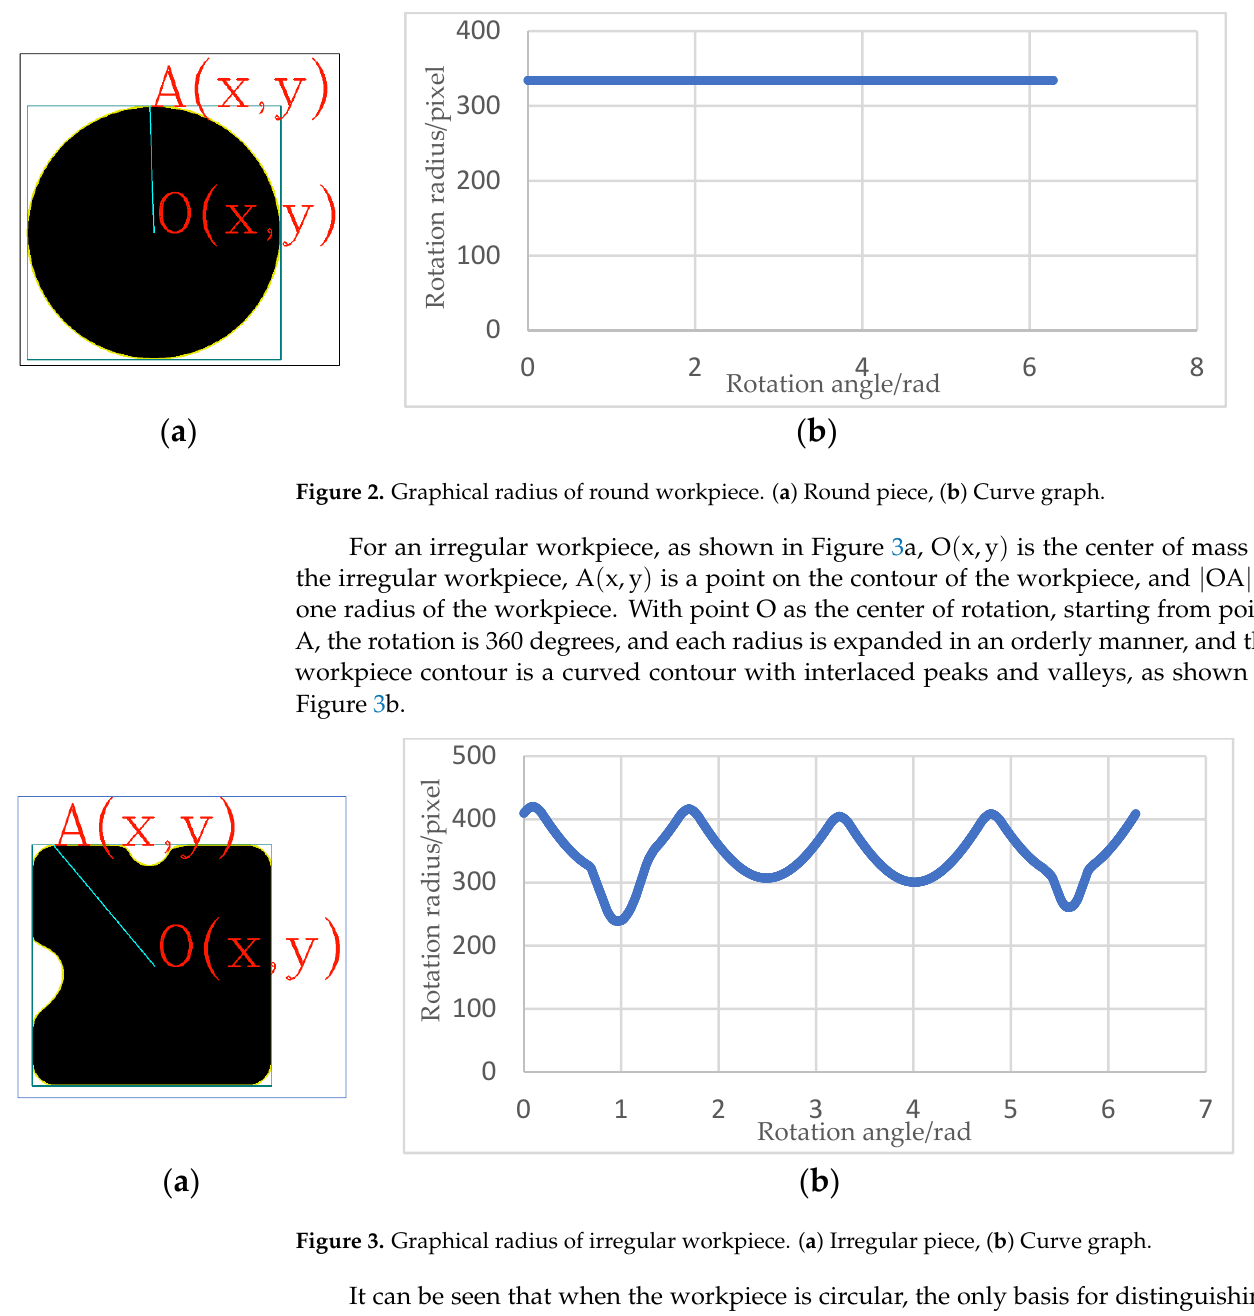
Figure 3. Graphical radius of irregular workpiece. ( a ) Irregular piece, ( b ) Curve graph. It can be seen that when the workpiece is circular, the only basis for distinguishing different workpieces is the difference in radius. When reasoning to the irregular workpieces, with the same initial starting point A ( x, y ) , the cumulative difference of the unfolded profile curve at each rotation angle can be used as a criterion for determining whether the target workpiece and the template one can be matched. Since the contour curves of different irregular workpieces unfolded according to the radius must be different, the contour curves of shaped workpiece image unfolding can be used as the basis for stencil matching. Usually, the target workpiece has a rotation angle relative to the template one, so their initial point A ( x, y ) is not consistent. In other words, the outline curve of the target workpiece and that of the template have a certain phase difference, as Figure 4